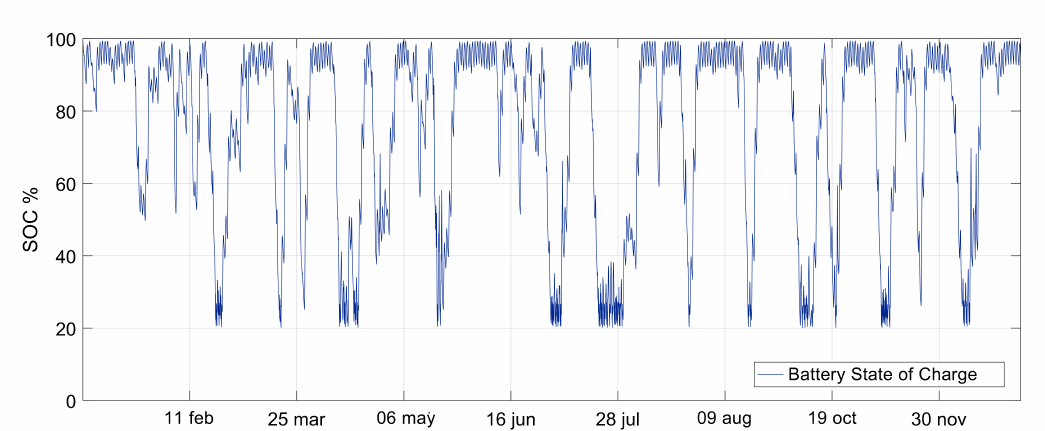
Figure 13. Battery bank annual state of charge (SOC).